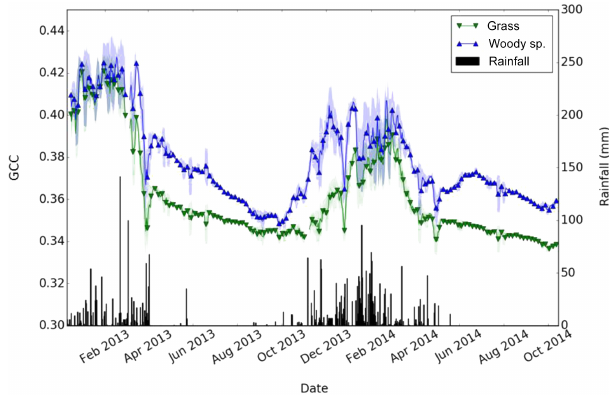
Figure 5. Daily rainfall (mm) and green chromatic coordinate (GCC) time series for grass and other woody green species (woody sp.) found in the savanna understory at the Howard Springs OzFlux site from December 2012 to October 2014. The GCC daily data are shown with an 8-day centred running mean (marked every 8 days for visualisation) applied. The standard error of the mean is given by the shading. The GCC time series represent the change in rela- tive greenness of grass and woody species, not the absolute sum of grass versus woody species biomass in the understory.